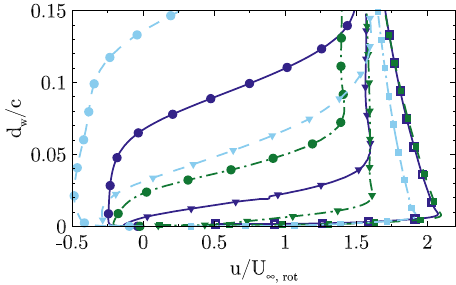
Figure 24. Stream-wise normalized velocity in the boundary layer u/U ∞ , rot at r/R = 0 . 136 and x c /c = [ 0 . 25 ; 0 . 5 ; 0 . 75 ] (squares; triangles; circles), for CaseT1.4 (solid), CaseT1.4-dYm05 (dashed dot) and CaseT1.4-dYp05 (dashed).